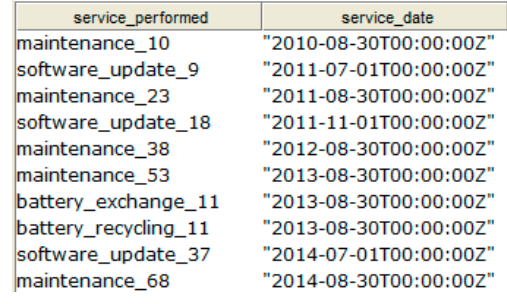
Figure 14. Services used by the client “Alexandre Grozel”.